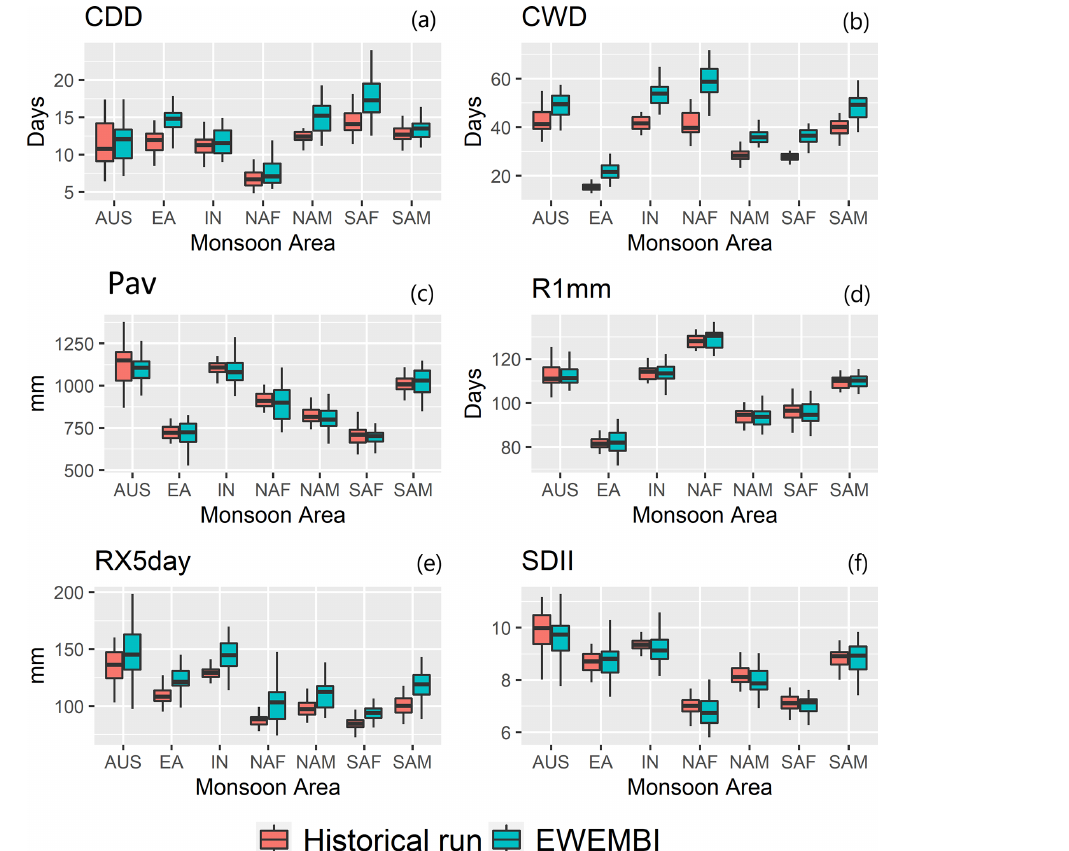
Figure C2. Comparison of the inter-annual variability of each monsoon index for the period 1976–2005 for the historical run simulation (red) and EWEMBI data (blue) for each monsoon system and for each monsoon indicator: (a) CDDs, (b) CDW, (c) P av , (d) R1mm, (e) RX5day, (f) SDII.